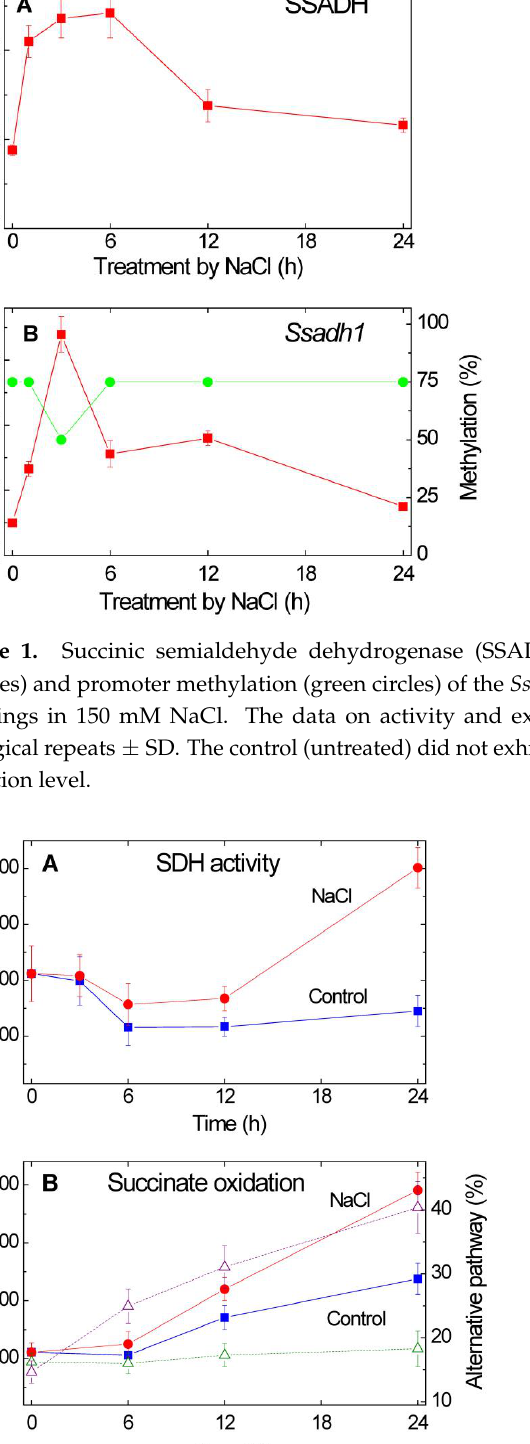
Figure 2. Succinate dehydrogenase (SDH) activity ( A ) and the rate of succinate oxidation by mito- chondria isolated from maize leaves ( B ) after the transfer of maize seedlings in 150 mM NaCl. The triangles and dotted lines indicate the involvement of cyanide-resistant (alternative) pathway in succinate oxidation. The data represent the means of three biological repeats ± SD. 2.3. Effect of Salt Stress on the Expression of Succinate Dehydrogenase Genes and Methylation of Their Promoters The exposure to NaCl induced a 2 – 3-fold increase in the expression of the genes Sdh1- 2 and Sdh2-3 encoding correspondingly the catalytic flavoprotein and the iron-sulfur pro- tein subunits, which was observed in 12 – 24 h (Figure 3A,B). The expression of the genes Sdh3-1 and Sdh4 encoding the anchoring subunits did not correlate with the activity of SDH decreasing significantly by 24 h of NaCl treatment (Figure 3C,D). Salt stress inhibited the expression of the Sdh4 gene throughout the experiment, while the expression of the Sdh3-1 gene strongly increased in the first 6 h of exposure to NaCl and then declined. The primers developed to study the expression of SDH subunits are presented in Table S1.